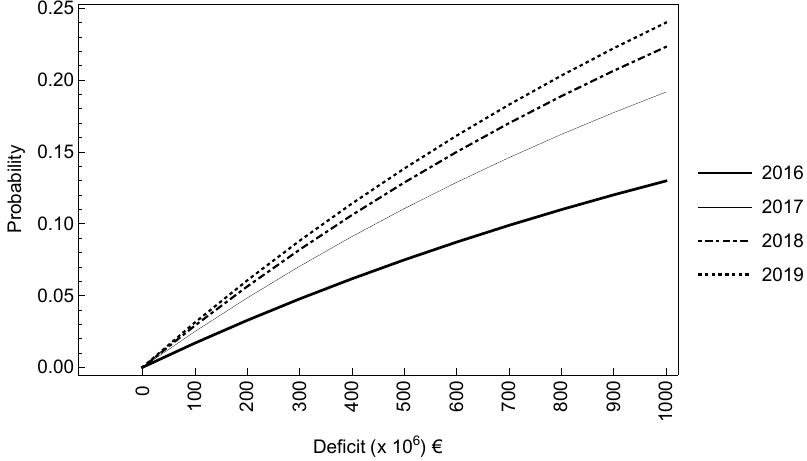
Figure 5. Probabilities ˜ ψ z ( r ) in 2016, 2017, 2018 and 2019. Source: Devised by the